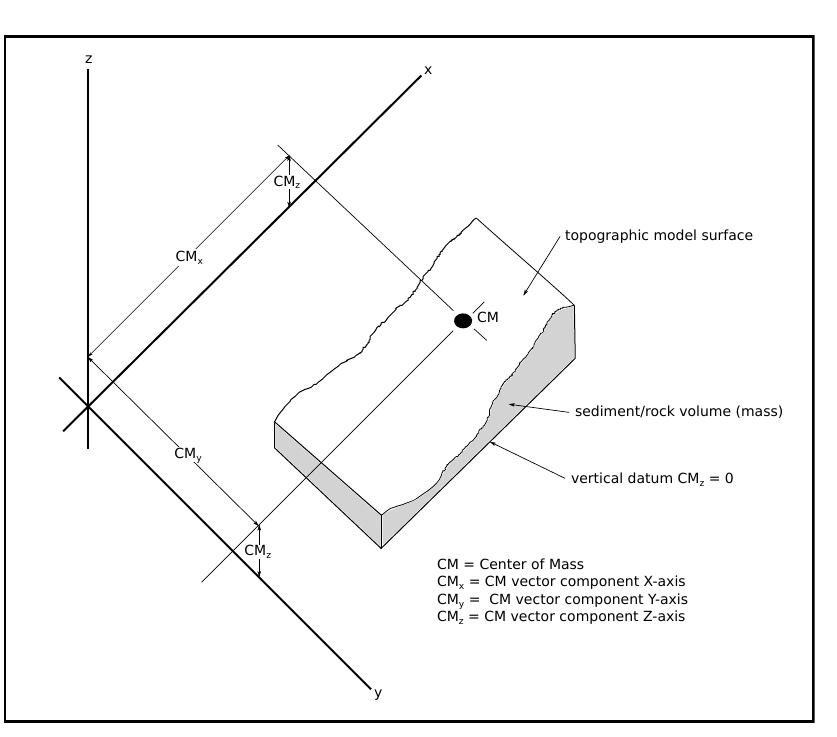
Figure 3. Center of mass (CM) for a topographic body in space. The center of mass here is defined as a point in three-dimensional space, whereby all of a finite body’s mass can be represented as a single point, such that forces acting on this point yield an identical dynamic response, as if these same forces were applied to the body